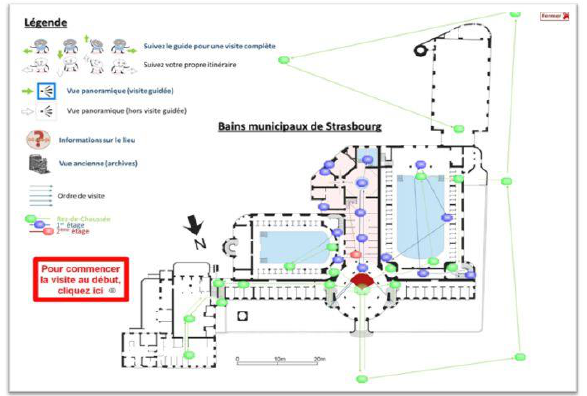
Figure 2 : Main map and tour scenario